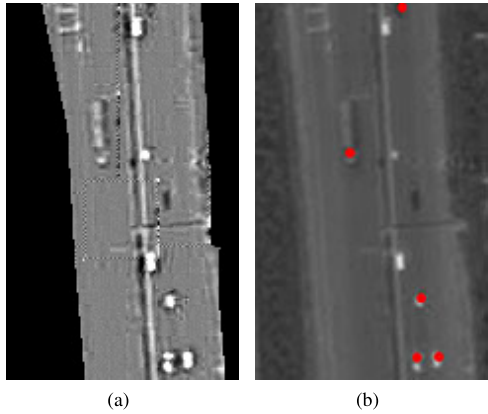
Figure 18: Illustration of local result.(a)Texture image. (b)Vehicle detection result is marked by red point, vehicles n- earby the road centerline are missed.